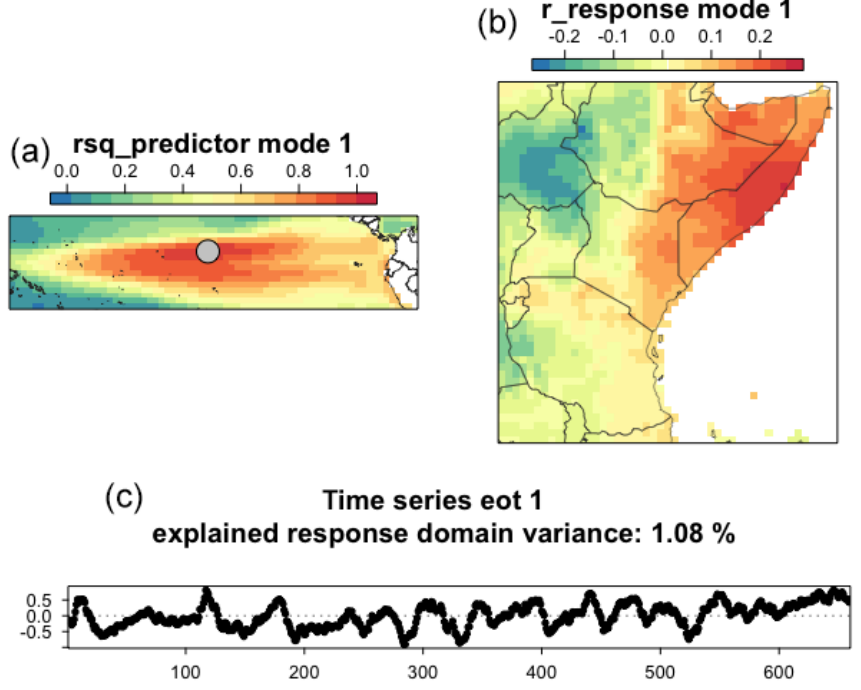
Figure A2. EOT analysis for the historical period from the GCM simulations. Panels as explained in Fig. A1: (a) the coefficients of determi- nation for the predictor field. (b) Correlation coefficients of each pixel of the eastern African (response) domain. (c) Time series at the base point of the mode.